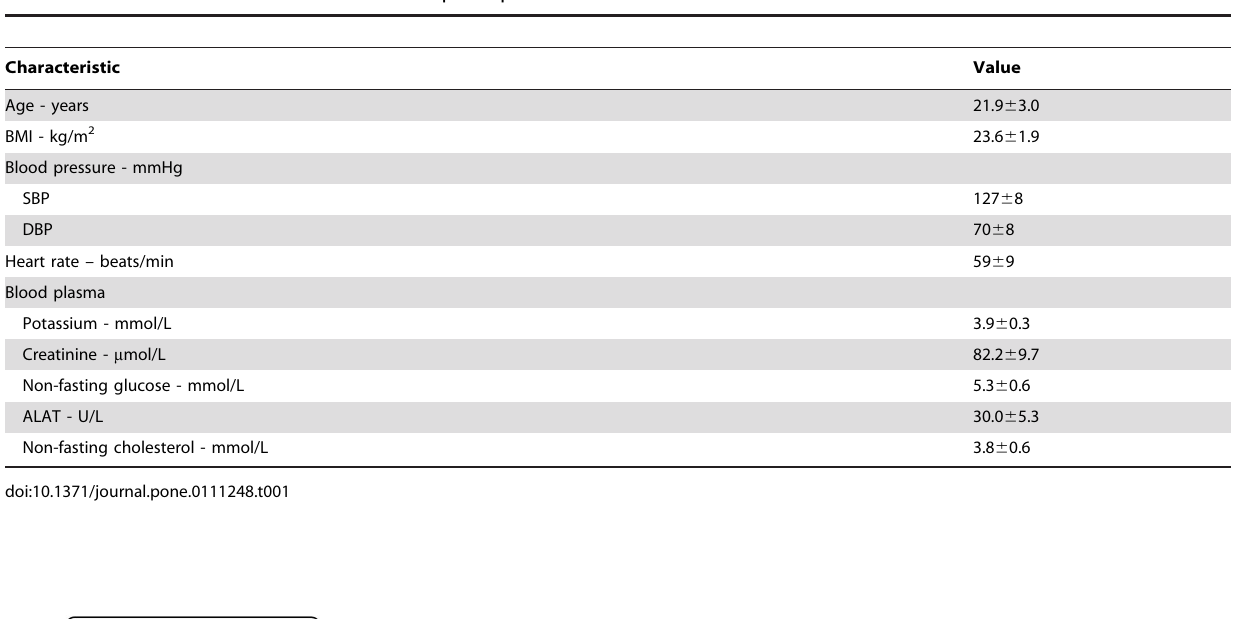
Table 1. Baseline characteristics of the male participants.